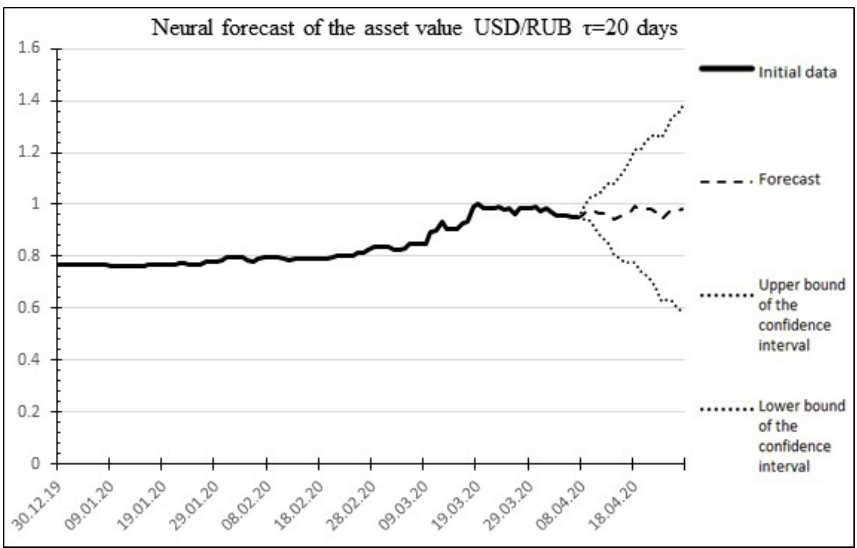
Figure 6. The result of the neural forecast for 20 days ahead for the USD/RUB